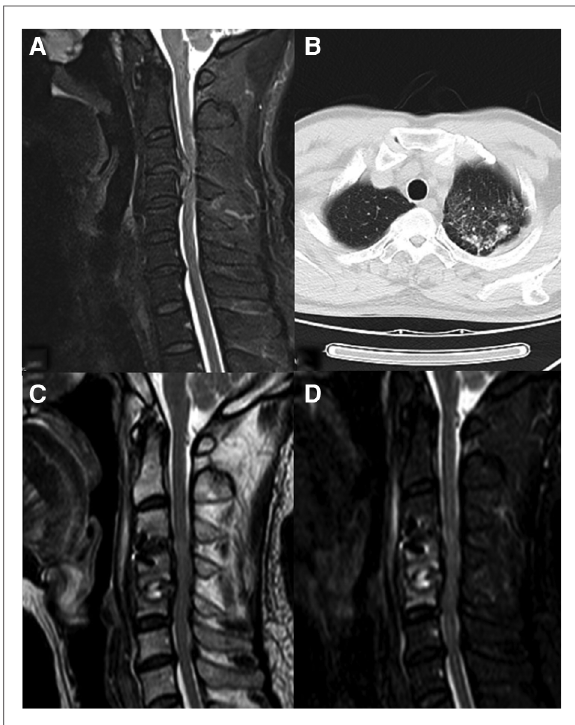
FIGURE 1 ( A ) Preoperative T2. ( B ) Preoperative chest CT. ( C ) Two months postoperative T2. ( D ) Two months postoperative fat reduction